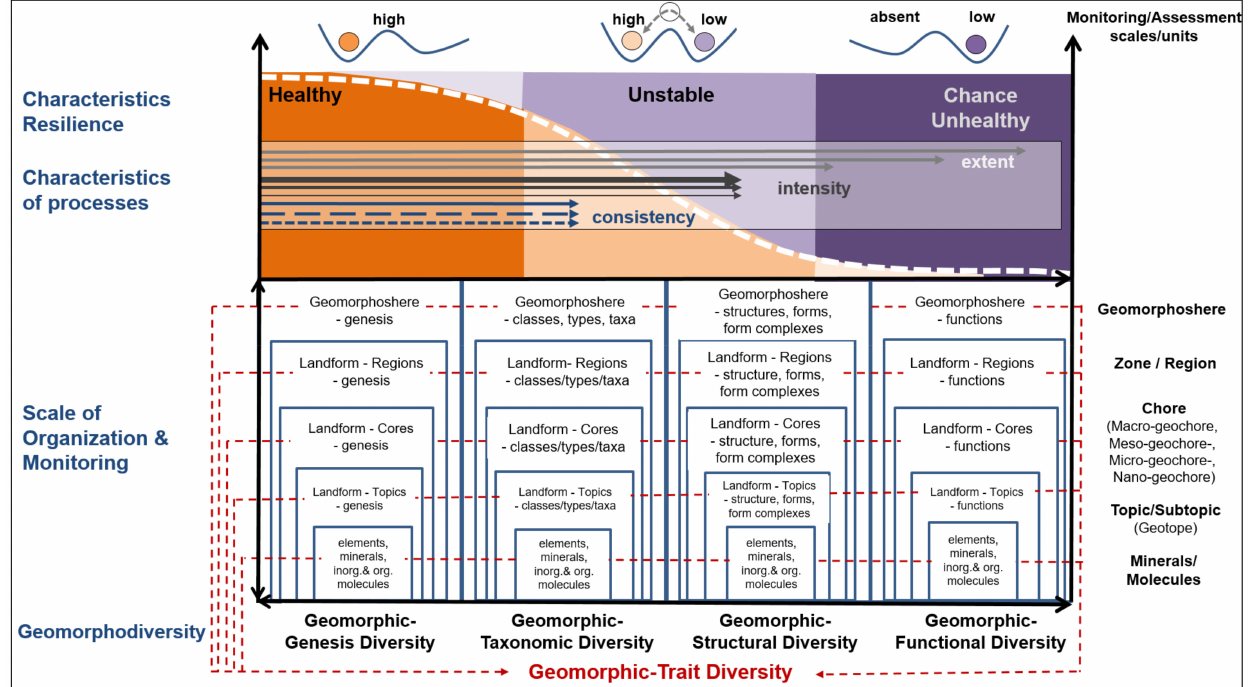
Figure 3. The five characteristics of geomorphodiversity exist on all the spatial, temporal, and directional scales of geomorphic organization (modified after Lausch et al.